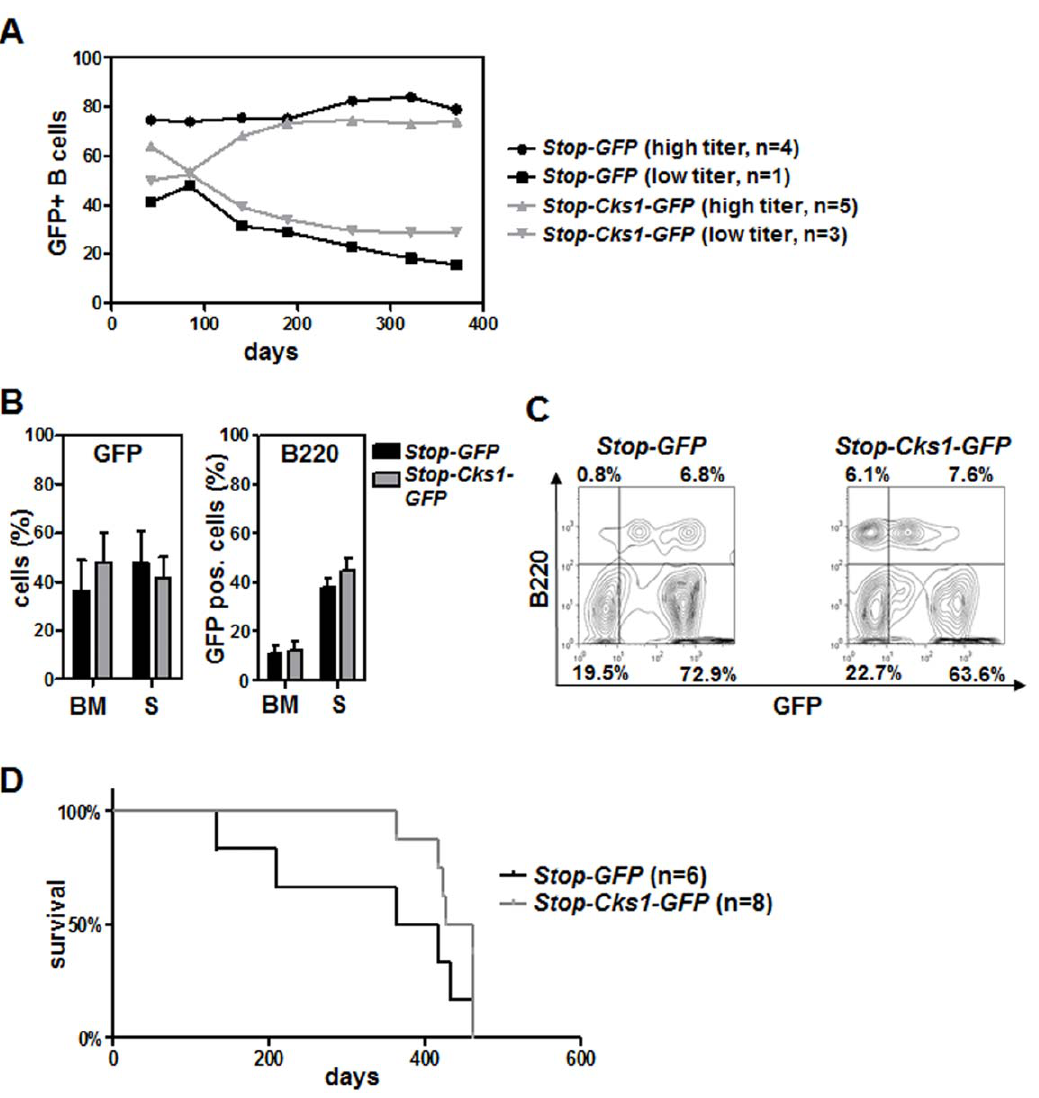
Figure 3. Targeted Cks1 overexpression is not sufficient to induce B cell lymphoproliferation or lymphoma. Data from two experiments (see Figure 2) are combined. One experiment with 2 6 10 6 transplanted cells and an infection rate of 15% (n=4 or 5 recipient mice) and one with 1 6 10 6 cells and an infection rate of 45% (n=2 or 3 recipient mice). A , Flow cytometric analysis of the percentage of GFP-positive B cells. Leucocytes were gated on B220 + cells. The analysis shows a divergence in the groups, some animals loose GFP positivity in the B cell compartment over time irrespective of the transduction efficiency. B , Left panel: Flow cytometric results of the bone marrow (BM) and spleen (S) for GFP positivity (of all cells, after lysis of erythrocytes). Right panel: percentage of GFP-positive cells in the B220 compartment of bone marrow (BM) and spleen (S). The analysis was performed on the day of indisposition and sacrifice. C , Representative images of flow cytometric analysis of GFP-positive B cells in the bone marrow. The genetic group is indicated. D , Survival of the CD19-Cre;Stop-Cks1-GFP group (median: 444 days) was identical to the survival